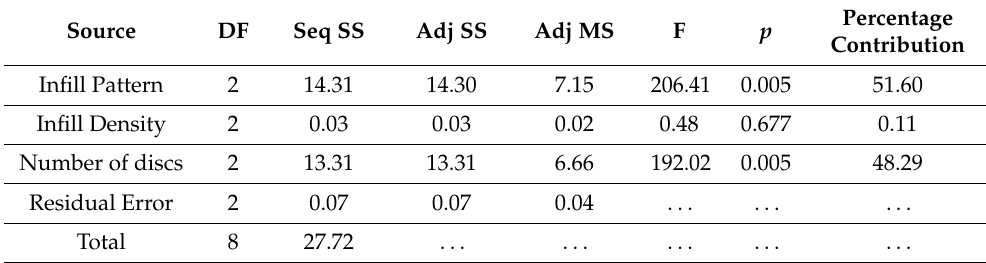
Table 6. ANOVA table for SN ratios of PLA samples.